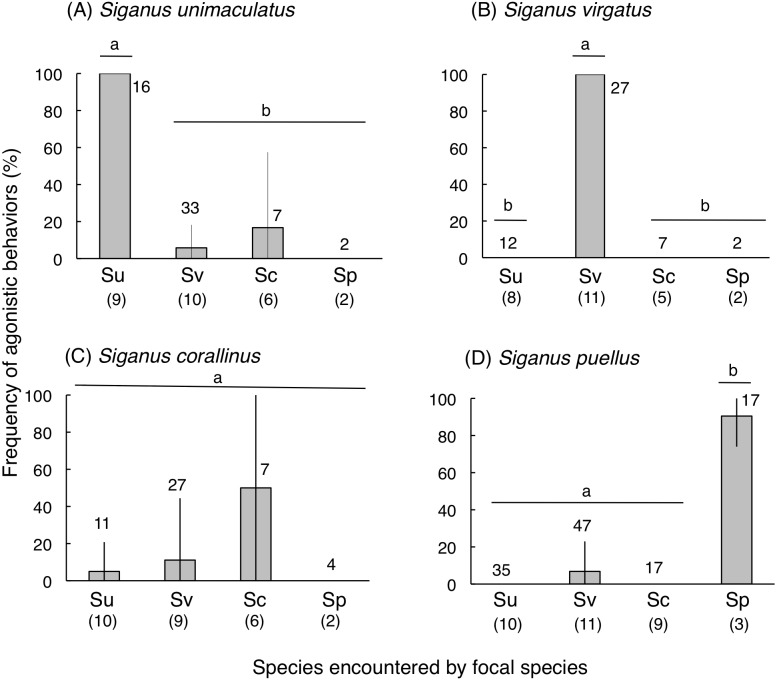
Frequency of “agonistic behaviors” among the four rabbitfish species (see ‘Materials and Methods’ for definition).(A) Siganus unimaculatus, (B) S virgatus, (C) S. corallinus, (D) S. puellus. Twelve pairs of fish were observed for each species. Species names are abbreviated as follows: Su, Siganus unimaculatus; Sv, S. virgatus; Sc, S. corallinus; Sp, S. puellus. Numbers in parentheses and above the bars represent the number of encountered pairs and the total number of encounters, respectively. Bars that are connected by a line with the same lower-case letter are not significantly different (Scheffé test, p > 0.05).Vertical bars represent standard deviations.